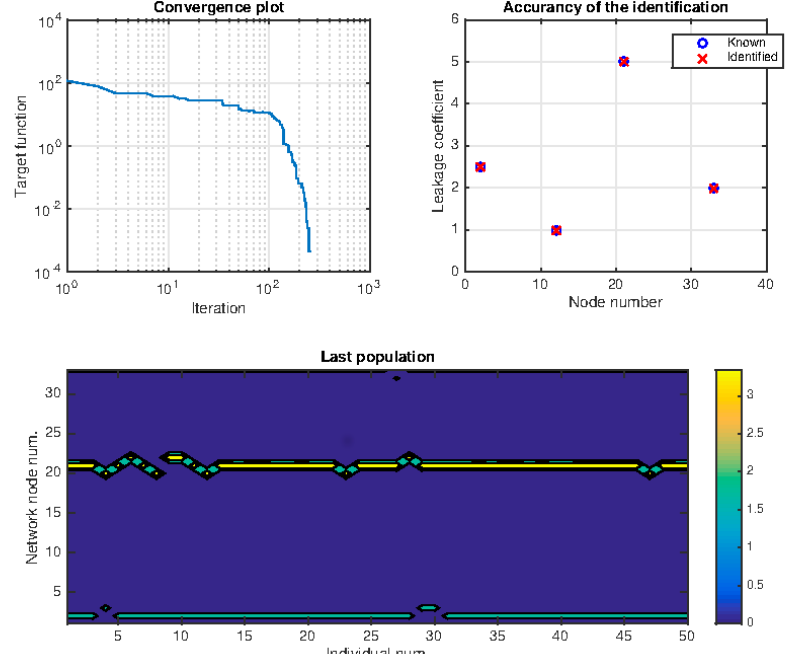
Figure 7. Convergence plot of the differential evolutive particle swarm optimization (DEPSO)-based optimization ( top left panel ), identified emitter coefficients and reference values of known leakages ( top right panel ), values of emitter coefficients across the last population ( lower panel ).